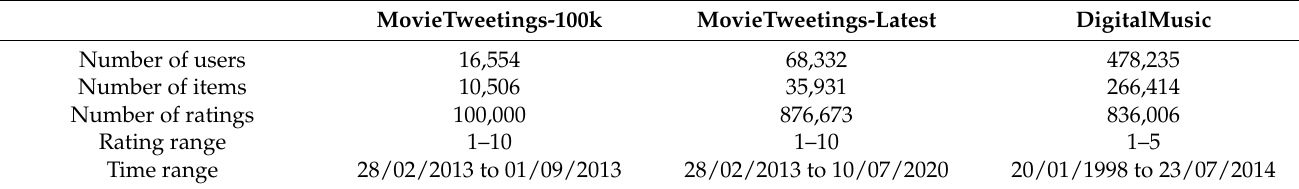
Table 2. The description of datasets.